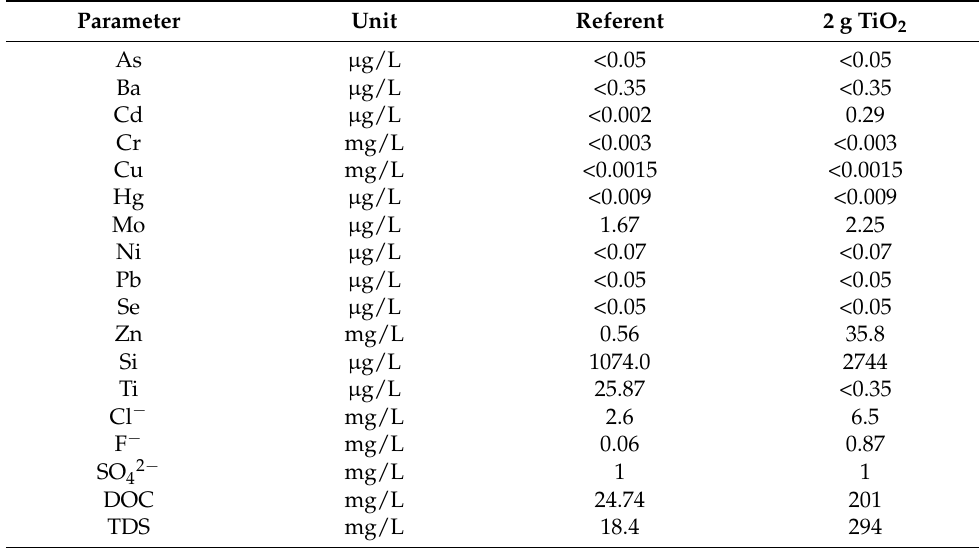
Table 5. Results of leaching test for green